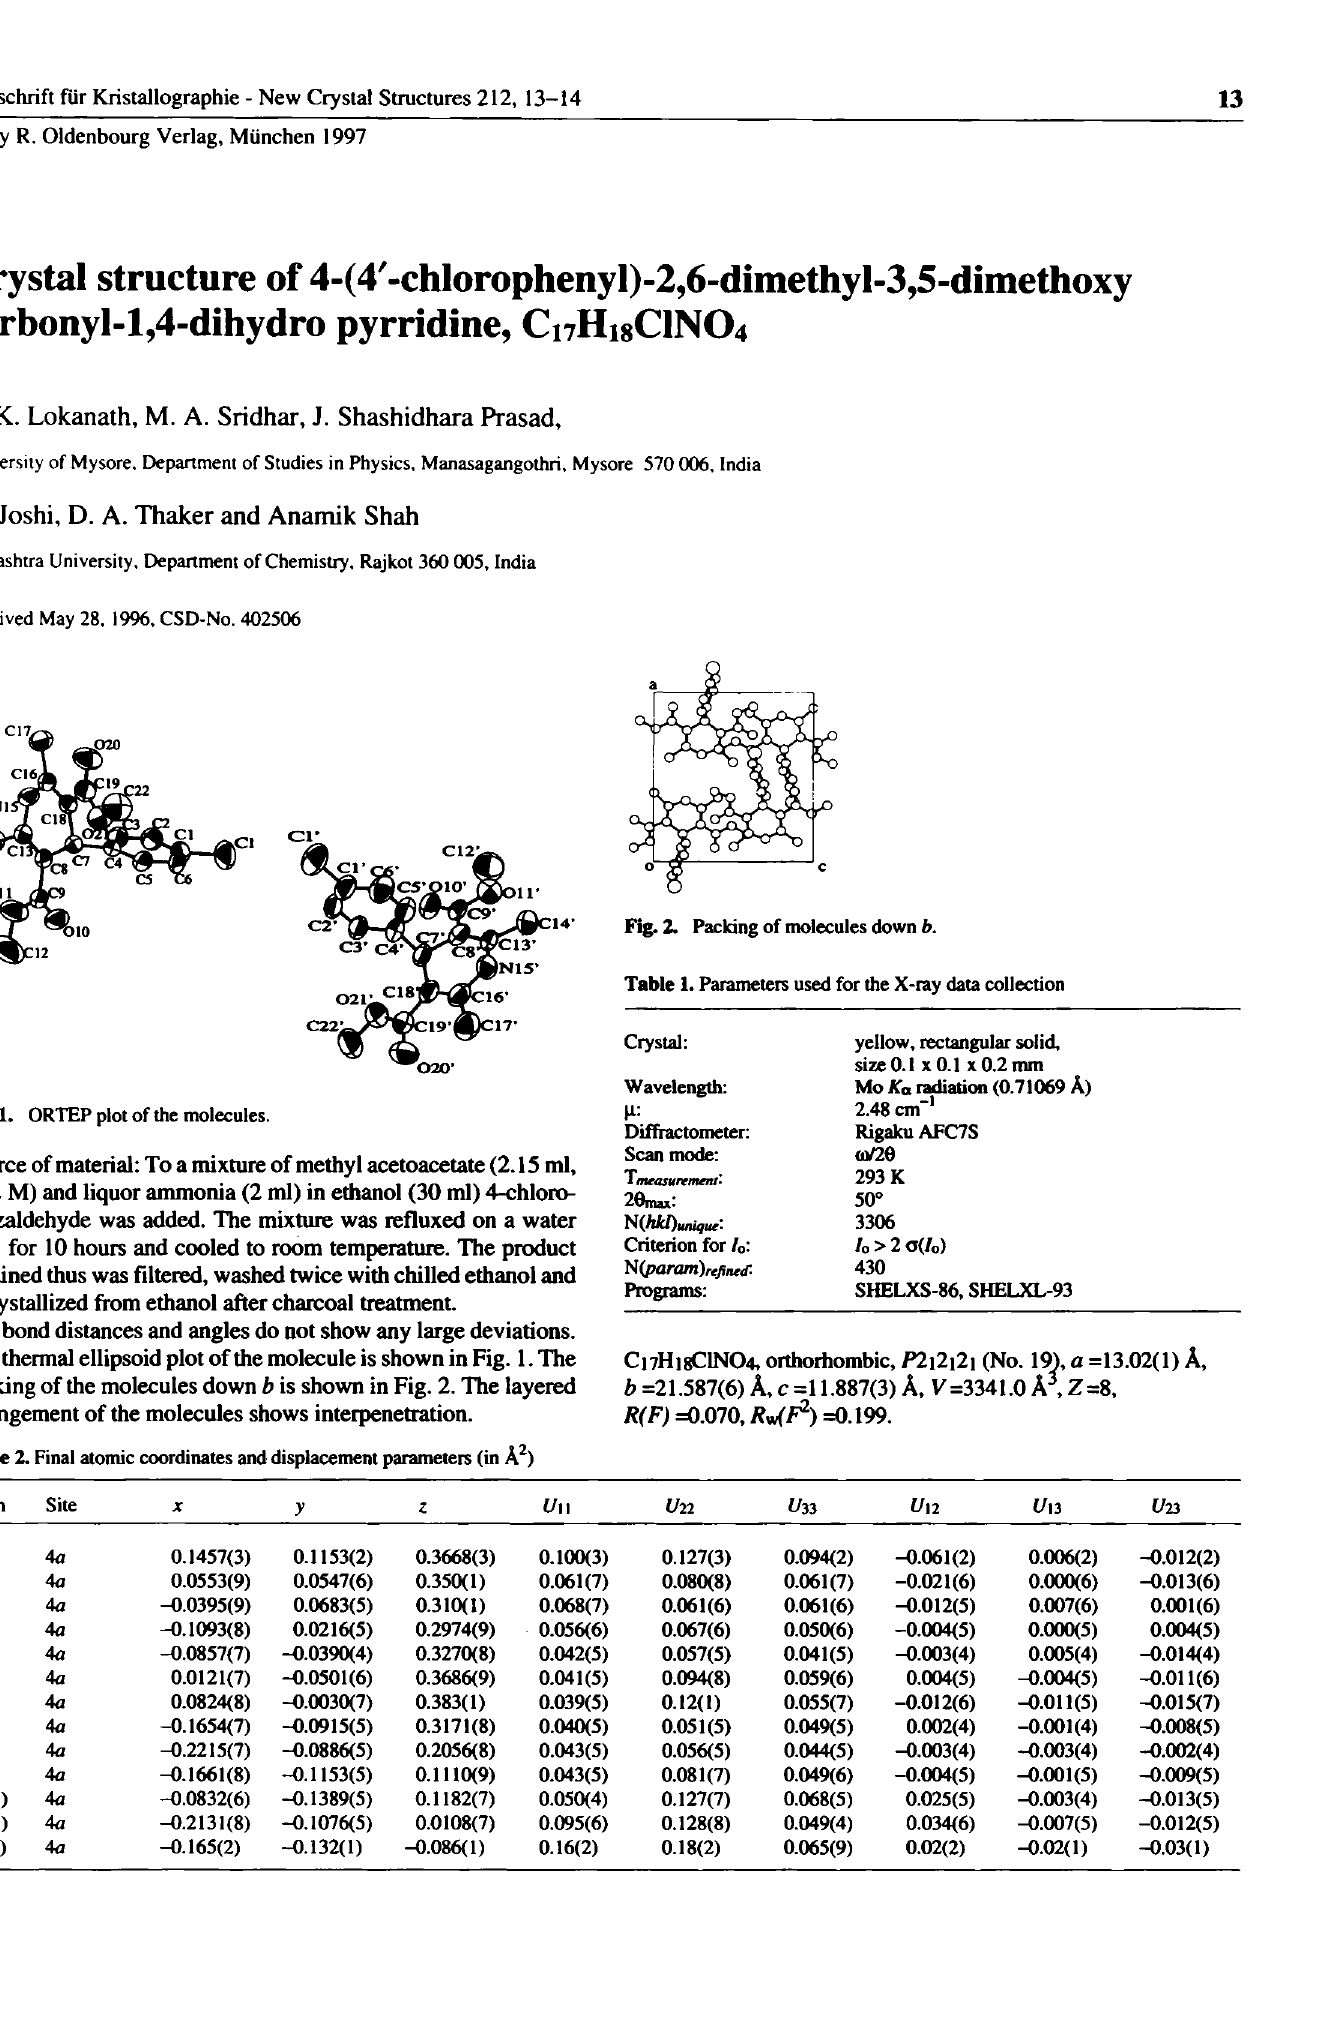
Table 2. Final atomic coordinates and displacement parameters (in Â 2 )